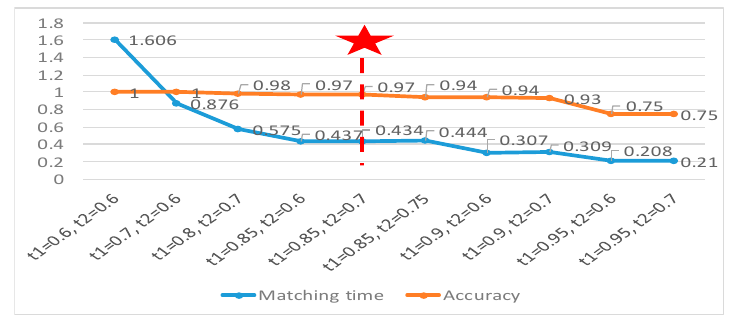
Figure 14. The matching time and the accuracy of a cross-hair mark testing on 100 test images.